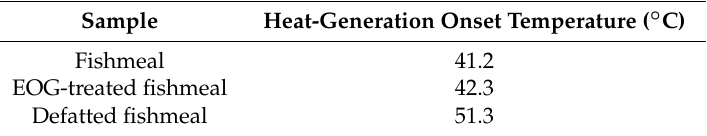
Table 3. Heat-generation onset temperatures and total heat generated for fishmeal (room temperature to 100 ◦